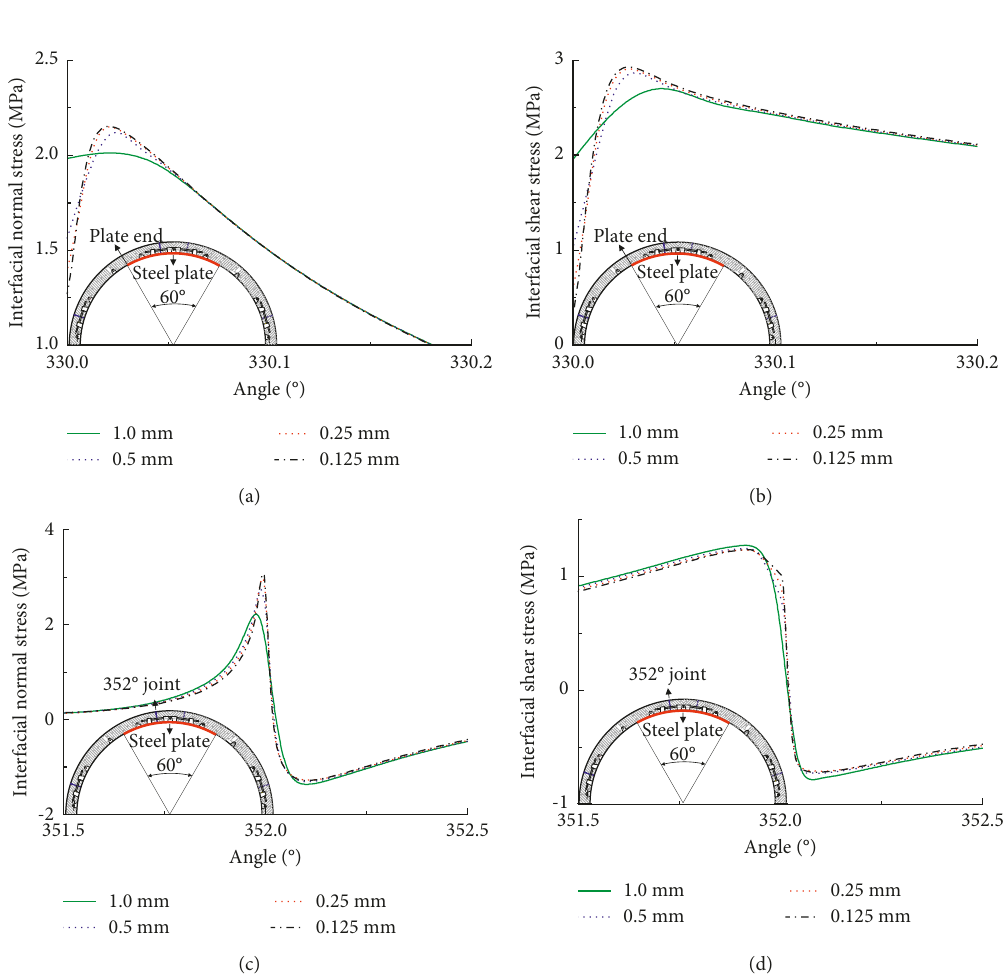
Figure 5: Interfacial stresses under different meshing. (a) Normal stress near plate end. (b) Shear stress near plate end. (c) Normal stresses near 352 ° joint. (d) Shear stress near 352 ° joint.